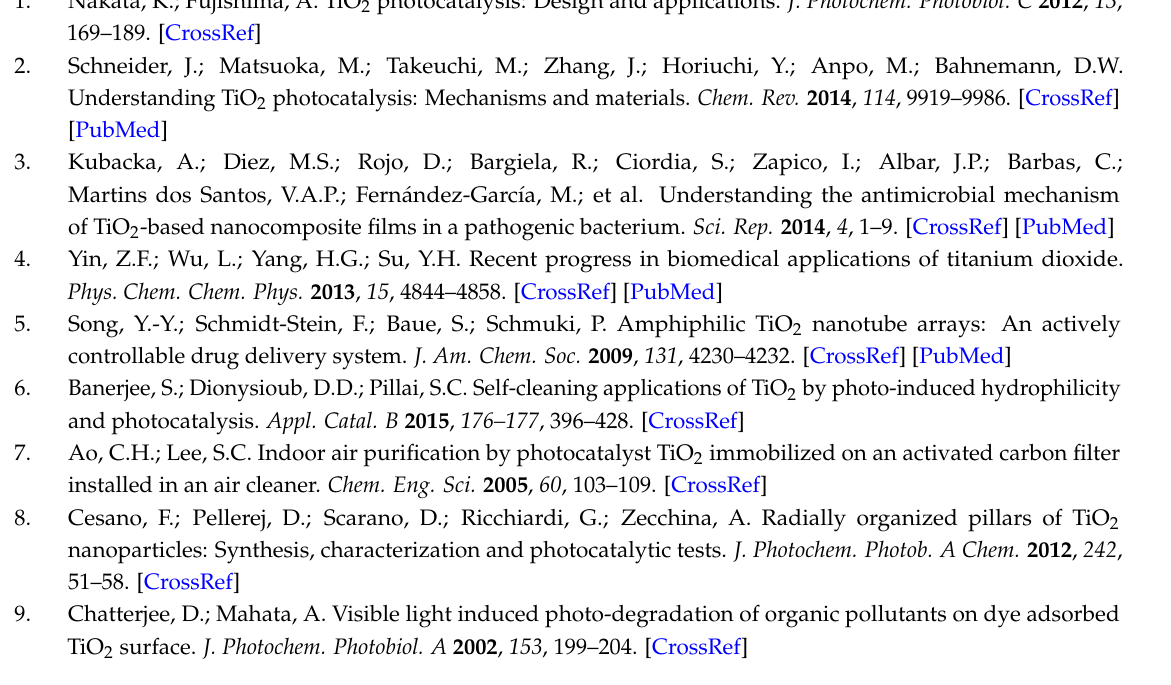
Figure S1: EDAX spectrum of TiO 2 /H 2 S, Figure S2: Particle size distributions (PSDs) of TiO 2 P25 (left panel) and of S-TiO 2 (right panel), Figure S3: Time dependence of C / C 0 upon solar light exposure of S-TiO 2 (red line) as compared to the TiO 2 P25 (black dotted line), for photodegradation of methylene blue, Figure S4: FTIR spectra, recorded before CO dosage, of TiO 2 (black curve) and TiO 2 /H 2 S (red curve), Table S1: Mean crystal sizes of anatase and rutile nanoparticles in TiO 2 P25 and S-TiO 2 samples, as obtained from XRD peak broadening (black and red patters in Figure